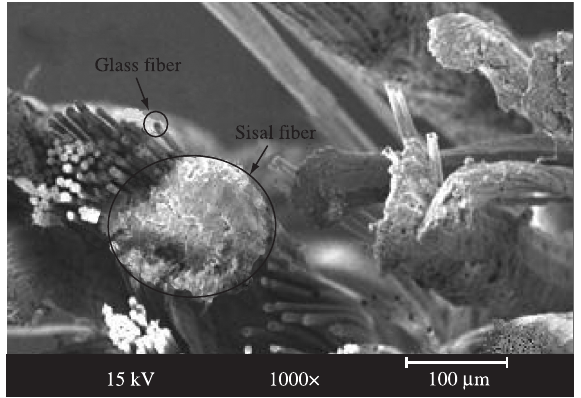
Figure 3. SEM micrograph of a tensile fractured composite with 75% glass fiber in the reinforcement.